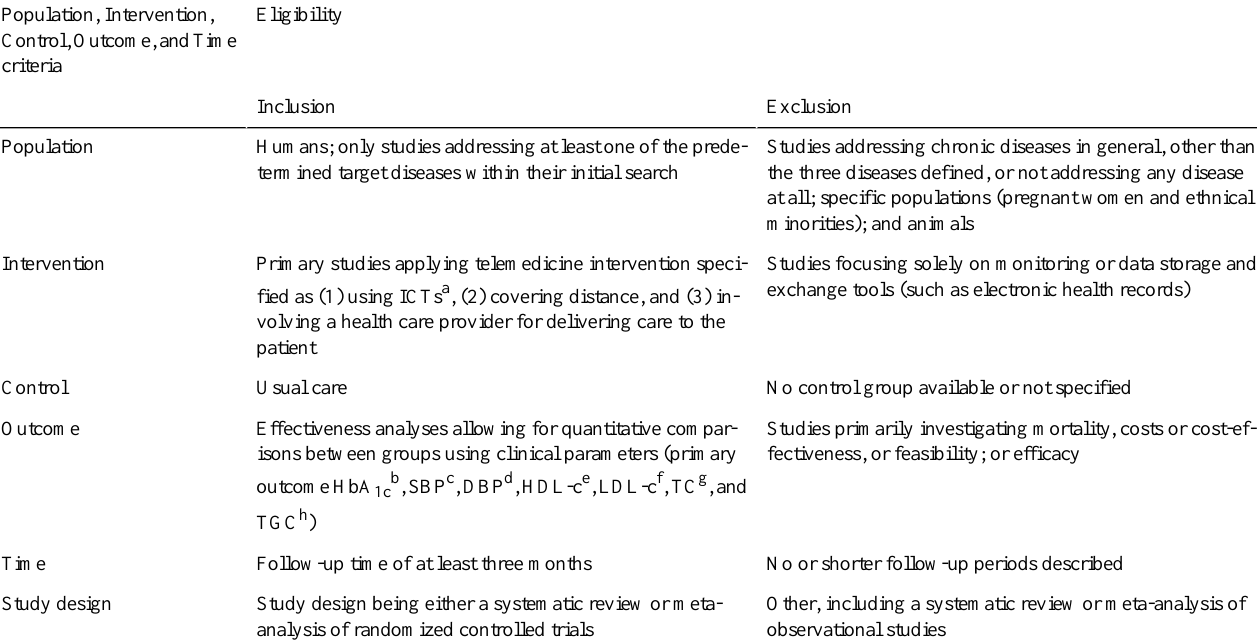
Table 1. Population, Intervention, Control, Outcome, and Time and eligibility criteria. EligibilityPopulation, Intervention, Control, Outcome, and Time